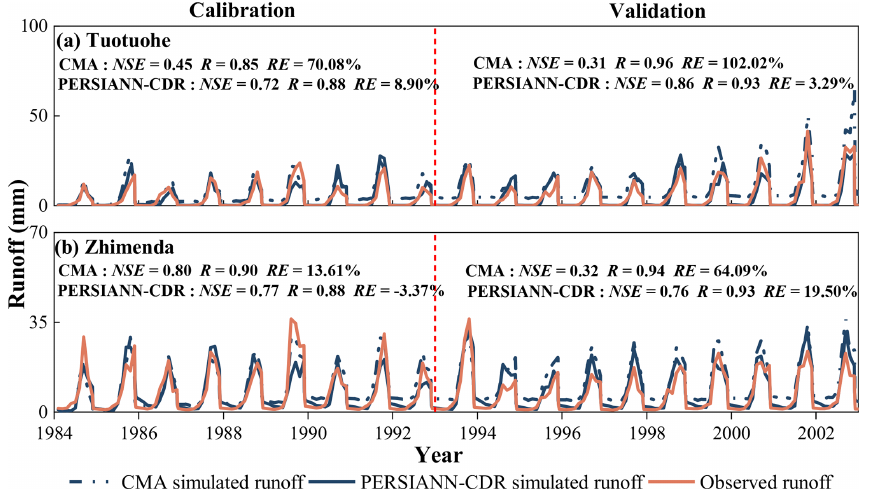
Figure 3. Comparison of simulated monthly runoff based on CMA precipitation and PERSIANN-CDR precipitation during the calibration period (1984–1993) and validation period (1994–2003) for (a) Tuotuohe station and (b) Zhimenda station.